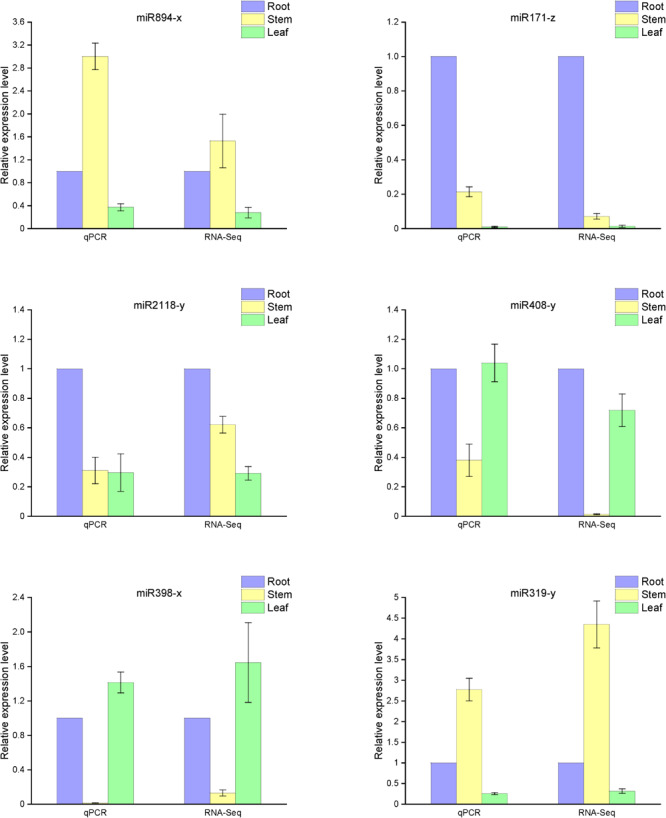
Expression levels of known miRNAs in the different organs of raspberry compared with the RNA-Seq results. The abundance of the random miRNAs was examined using stem-loop qRT-PCR. The expression levels of miRNAs were normalized to the level of U6 snRNA. Fold changes in the expression levels of miRNAs were estimated by the 2–ΔΔCT method relative to the levels in the roots. Data are reported as mean ± standard error (SE) for three independent experiments.